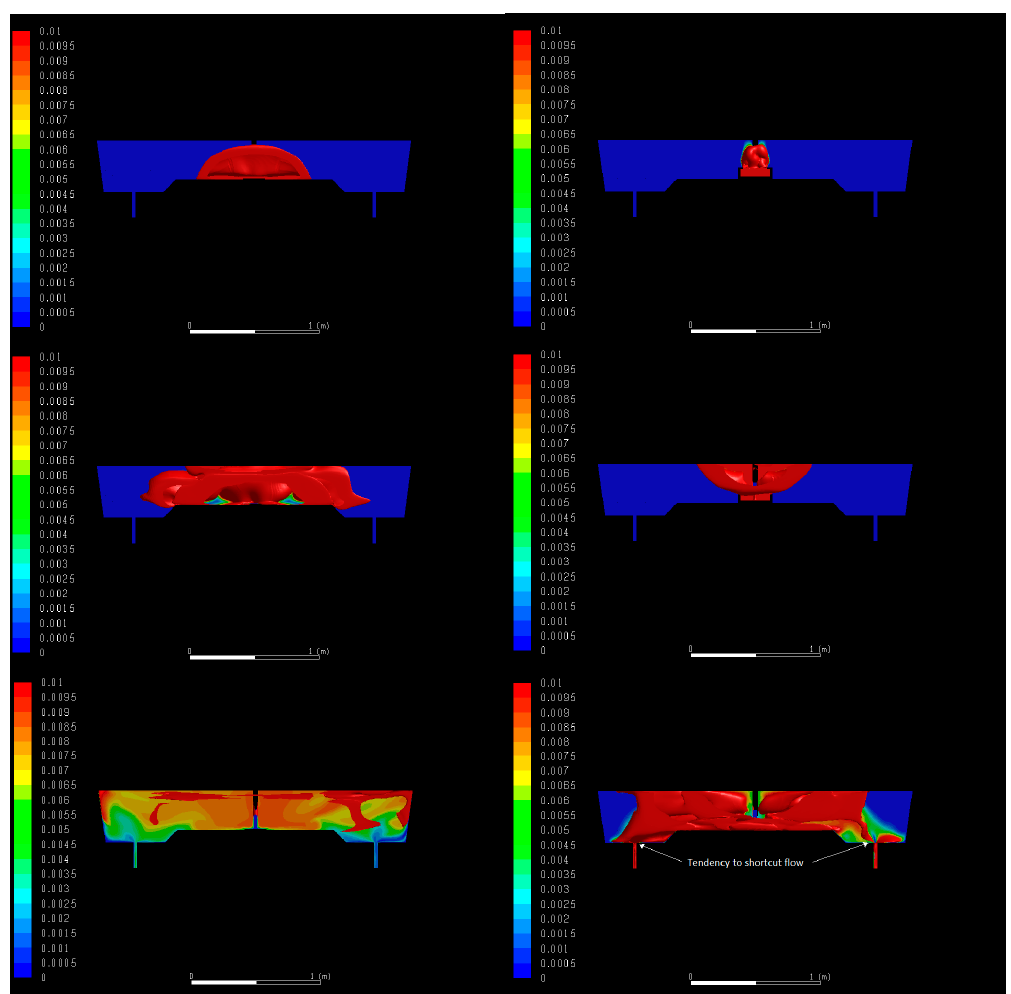
Figure 4. Comparison of fluid flow for “Spheric” impact pad and for standard impact pad at simulated casting speed 0.8 m min − 1 —CFD simulation.